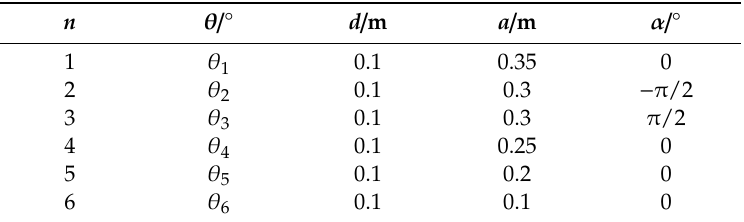
Table 14. The DH parameters of Bot 2 .